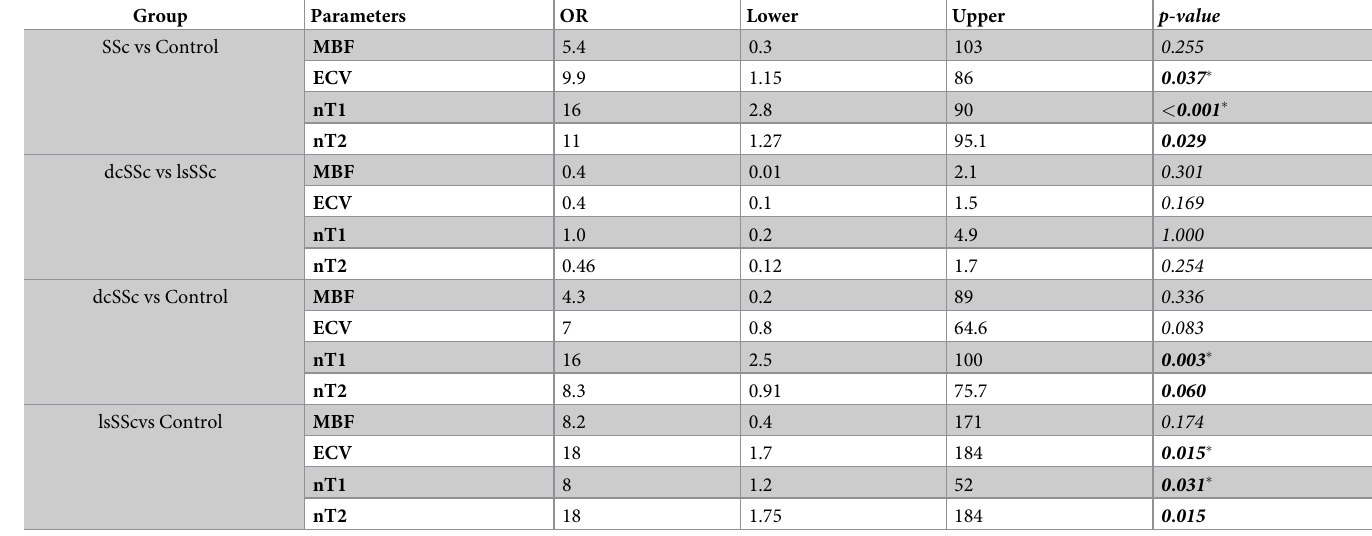
Table 4. Logistic Regression Analysis for the significant and independent predictors in patients with SSc.